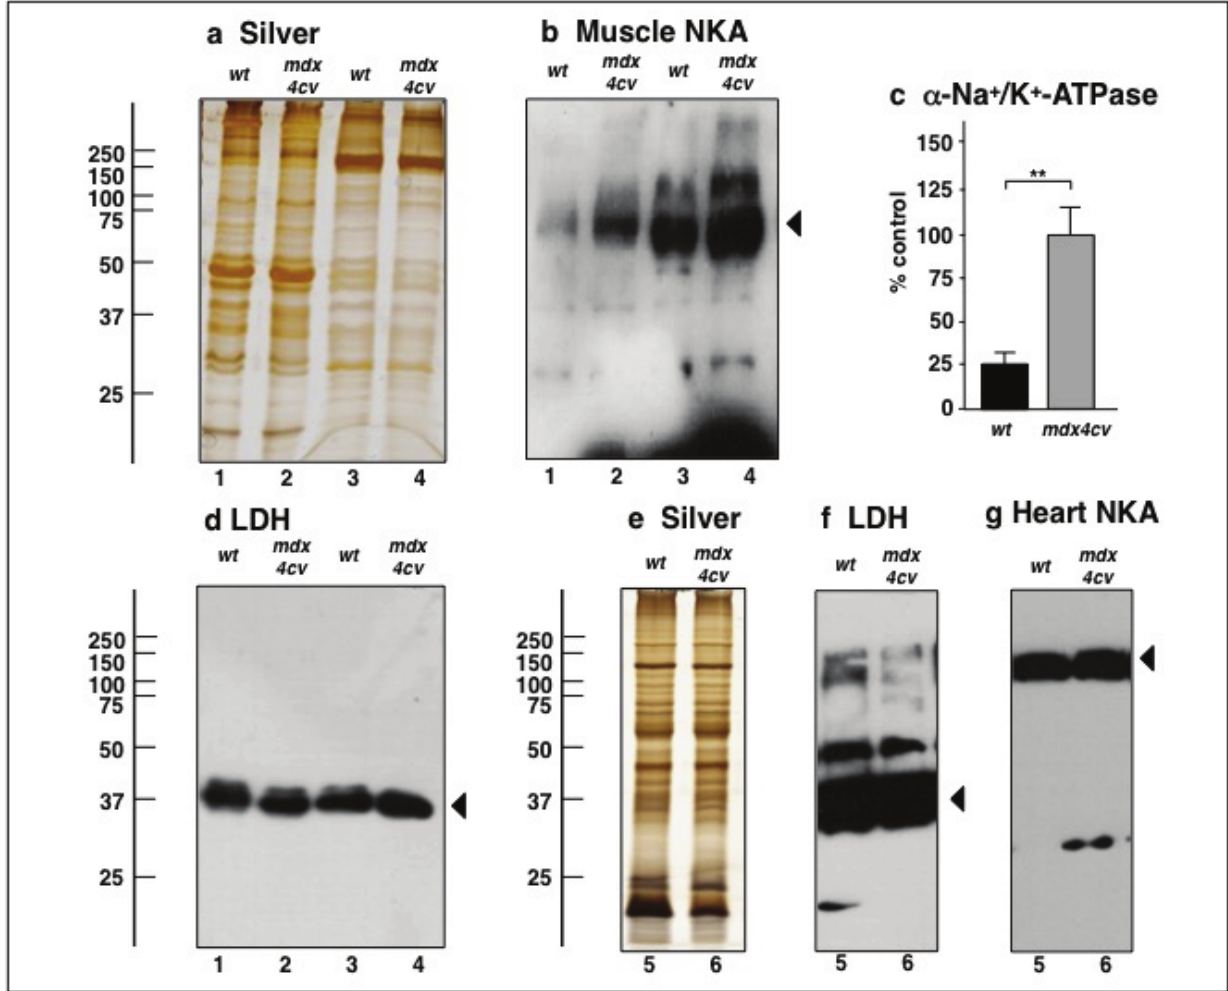
Figure 6. Immunoblot analysis of the Na + /K + -ATPase from mdx-4cv skeletal and cardiac muscles. Shown are representative silver-stained gels ( a , e ) and immunoblots ( b , d , f , g ). Lanes 1 to 6 represent total extracts from non-dystrophic wild type ( wt ) skeletal muscle, total extracts from dystrophic mdx-4cv skeletal muscle, crude microsomes from wt skeletal muscle, crude microsomes form mdx-4cv skeletal muscle, total extracts from wt heart, and total extracts from mdx-4cv heart, respectively. Blots were labelled with antibodies to the Na + /K + -ATPase ( b , g ), and lactate dehydrogenase (LDH; as a loading control) ( d , f ). Arrowheads indicate immuno-labelled bands. Graphical representations of the immuno-decoration levels for the Na + /K + -ATPase in normal versus mdx-4cv microsomes are shown in panel ( c ): Student’s t -test, unpaired; n = 4; ** p < 0.01. See supplementary Figure S2 for the graphical presentation of LDH and the cardiac Na + /K +